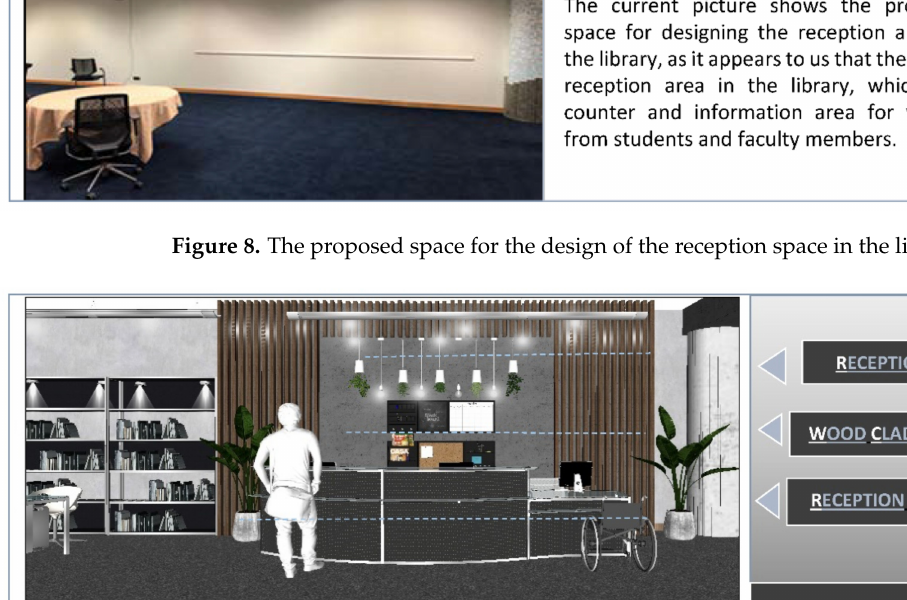
Figure 9. The perspective of reception and inquiries